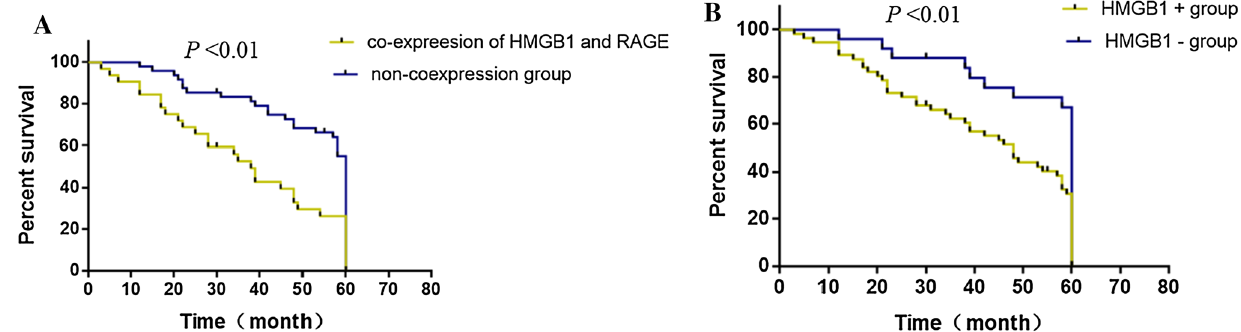
Fig. 4 A Overall Survival curves depicting the survival rates for the patient group with co-expression of HMGB1 and RAGE when compared to non-expression group pertinent to the ESCC patients. B Survival curves for the patients group with HMGB1 ( +) and without HMGB1 (-). *P <